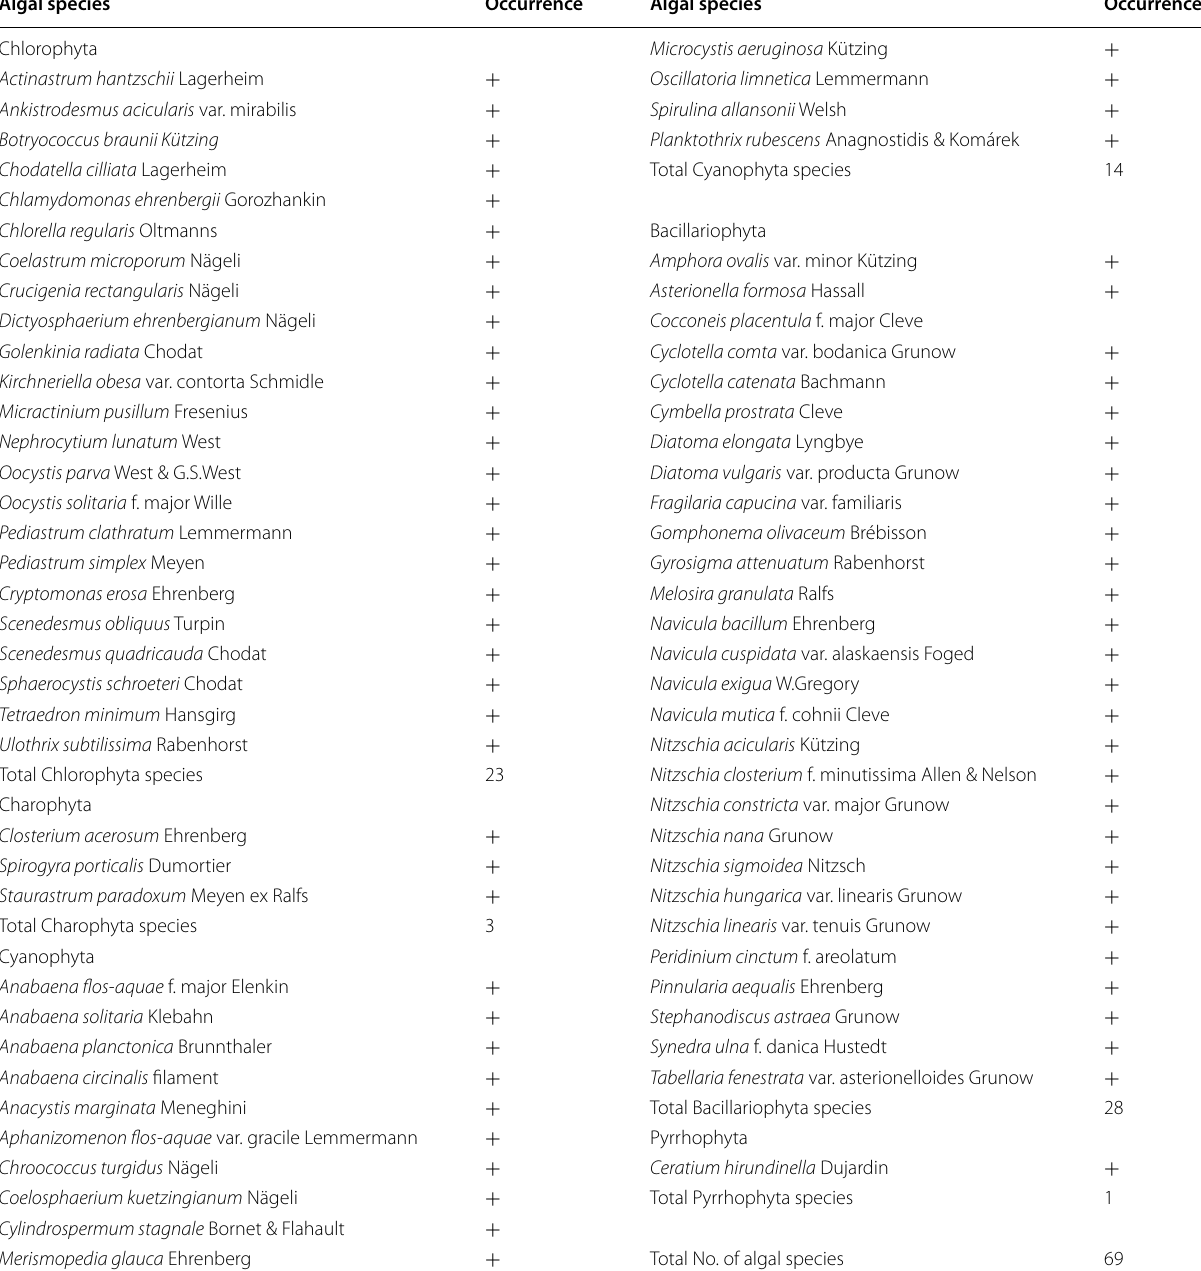
Table 1 List of recorded species in the Nile River samples Algal